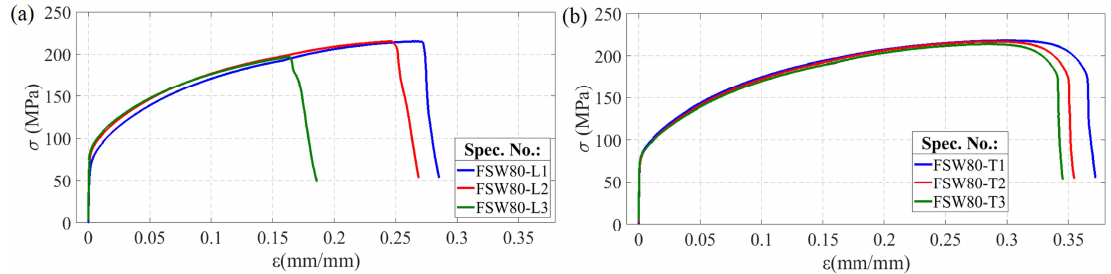
Figure 8. Fracture location of the tensile FSW joint samples.